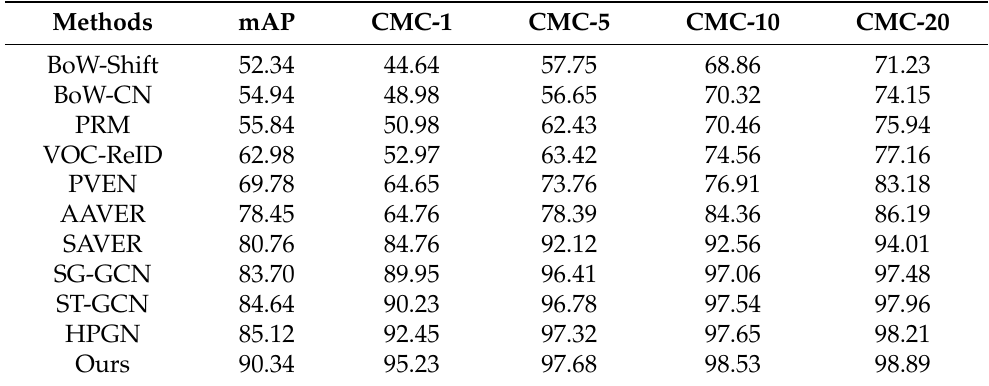
Table 4. Comparisons results(%) of object Re-ID on PRAI-1581 dataset by using the metrics of mAP, CMC-1, CMC-5, CMC-10 and CMC-20,